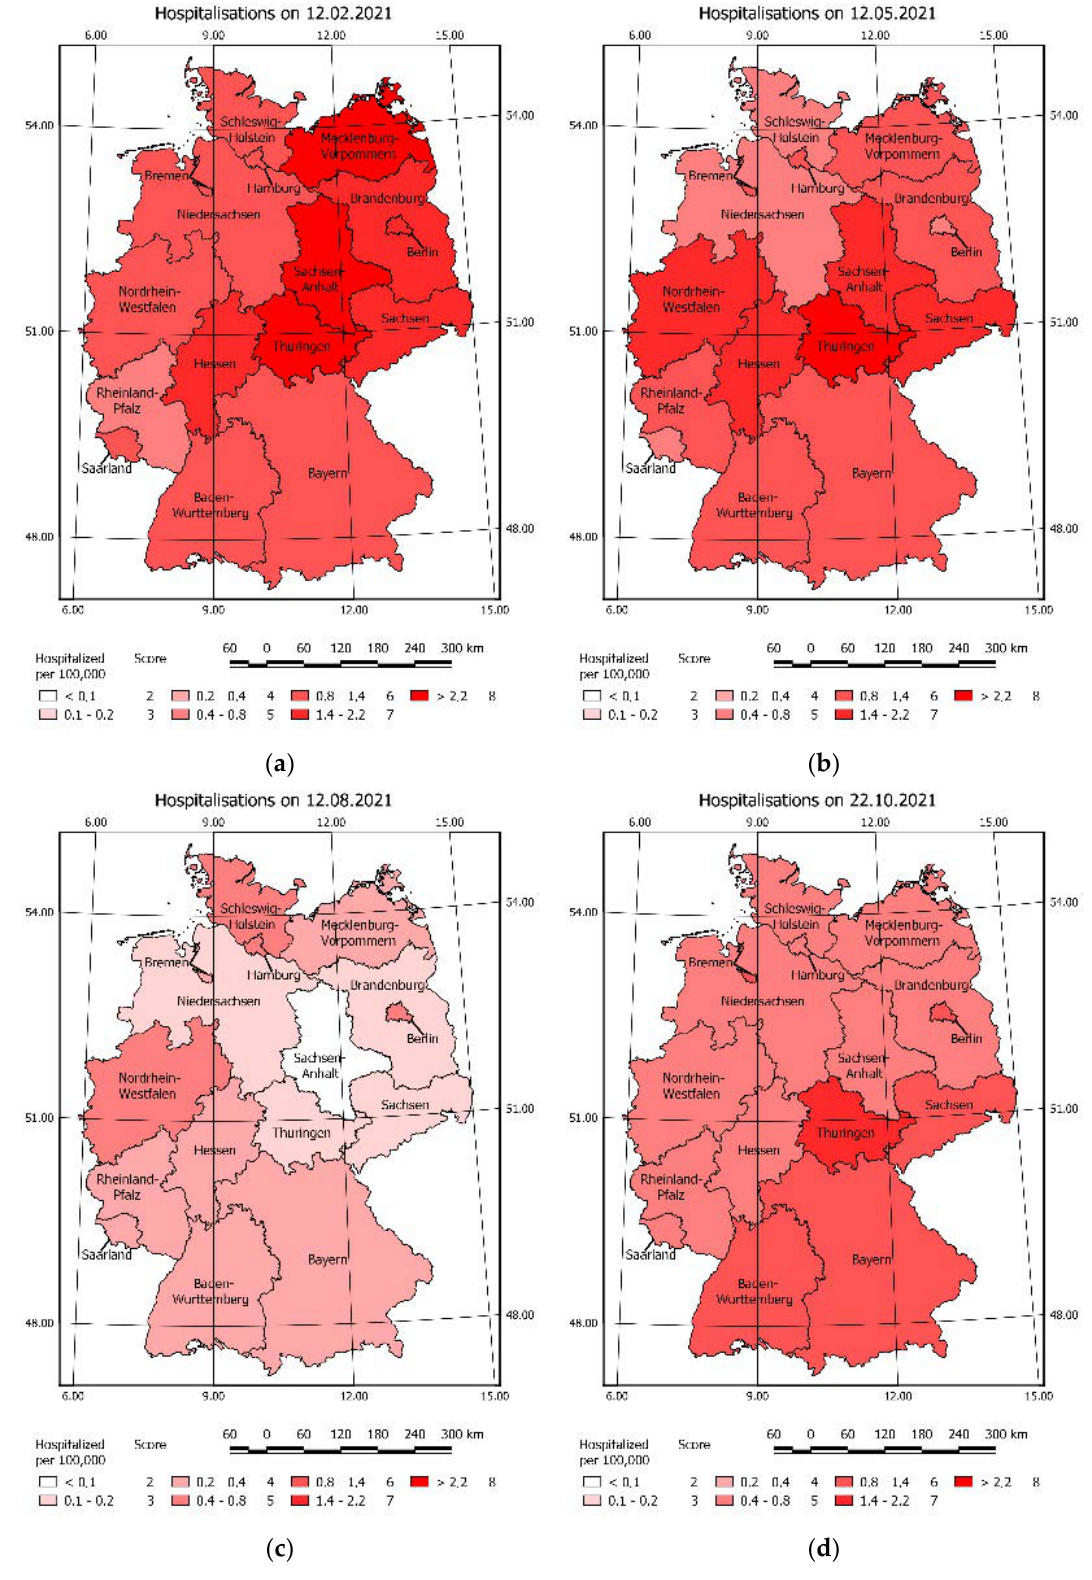
Figure A2. COVID-19 Hospitalisations on selected days: ( a ) 12 February 2021 ( b ) 12 May 2021 ( c ) 12 August 2021, ( d ) 22 October 2021.